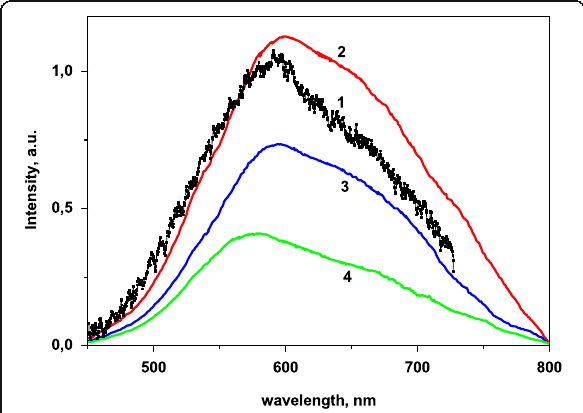
Fig. 5 Emission spectra of the La 1 − x Ca x VO 4 samples, λ ex = 310 ( 1 – 3 ) and 290 nm ( 4 ); x = 0 ( 1 ), 0.2 ( 2 ), and 0.1 ( 3 , 4 ), T = 77